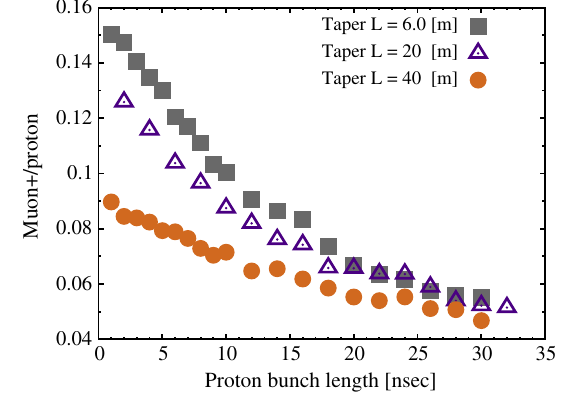
FIG. 14. Accepted positive muons as a function of the proton bunch length for three different taper lengths. The target field is 20 T, and the final field is 3.5